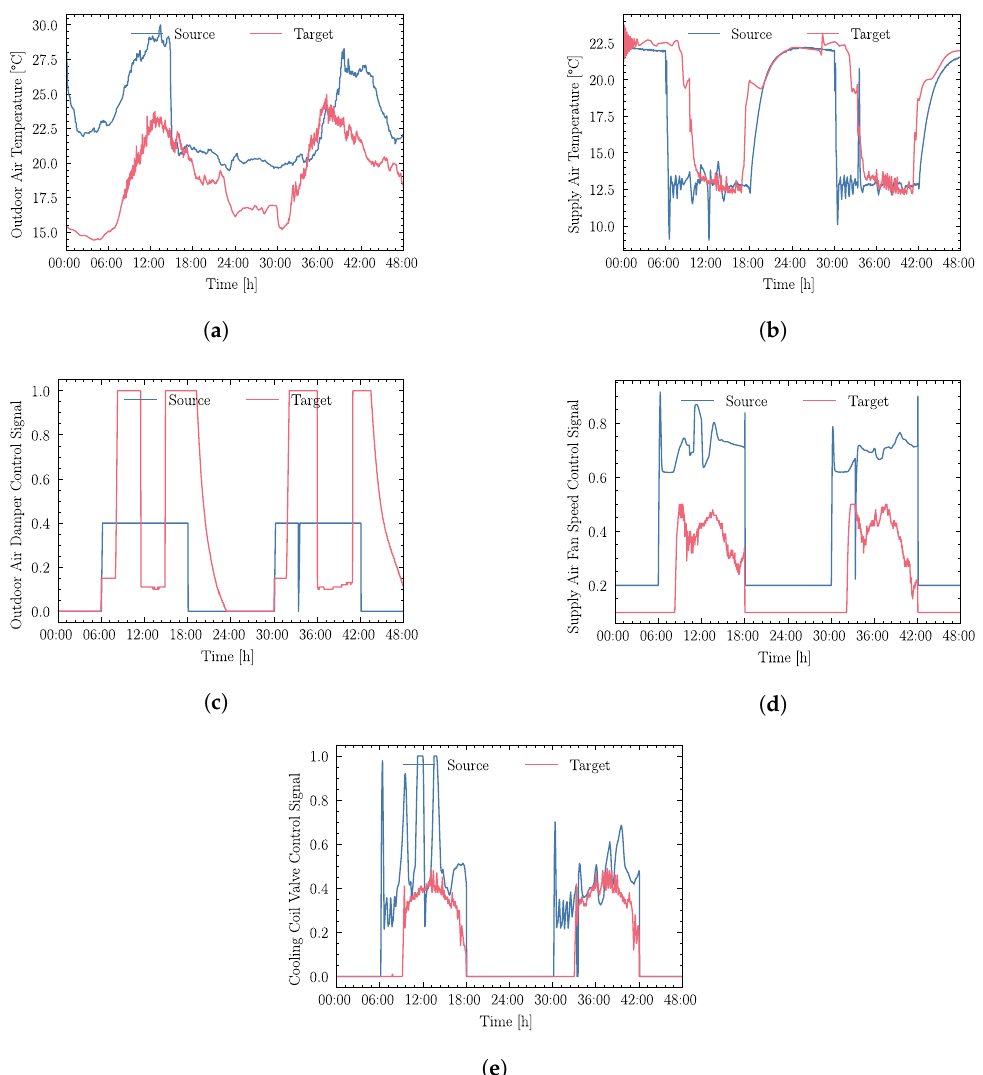
Figure 6. Comparison between the measurements observed in the source and target datasets